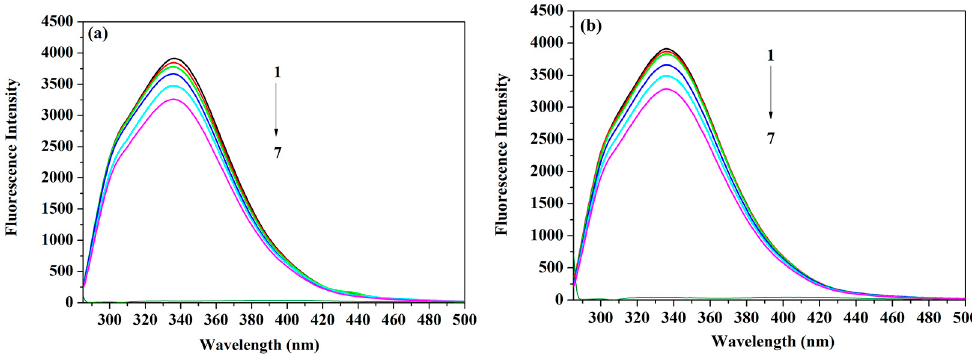
Figure 2. Representative spectra of ( a ) HSA (human serum albumin)-ACV (0, 3.5, 7, 15, 25 and 35 µ M) and ACV only (25 µ M) ( b ) HSA-PNV (0, 3.5, 8.0, 17, 28 and 35 µ M) and PNV only (28 µ M), shown as peaks 1–7 for each drug at temperature 298 K.